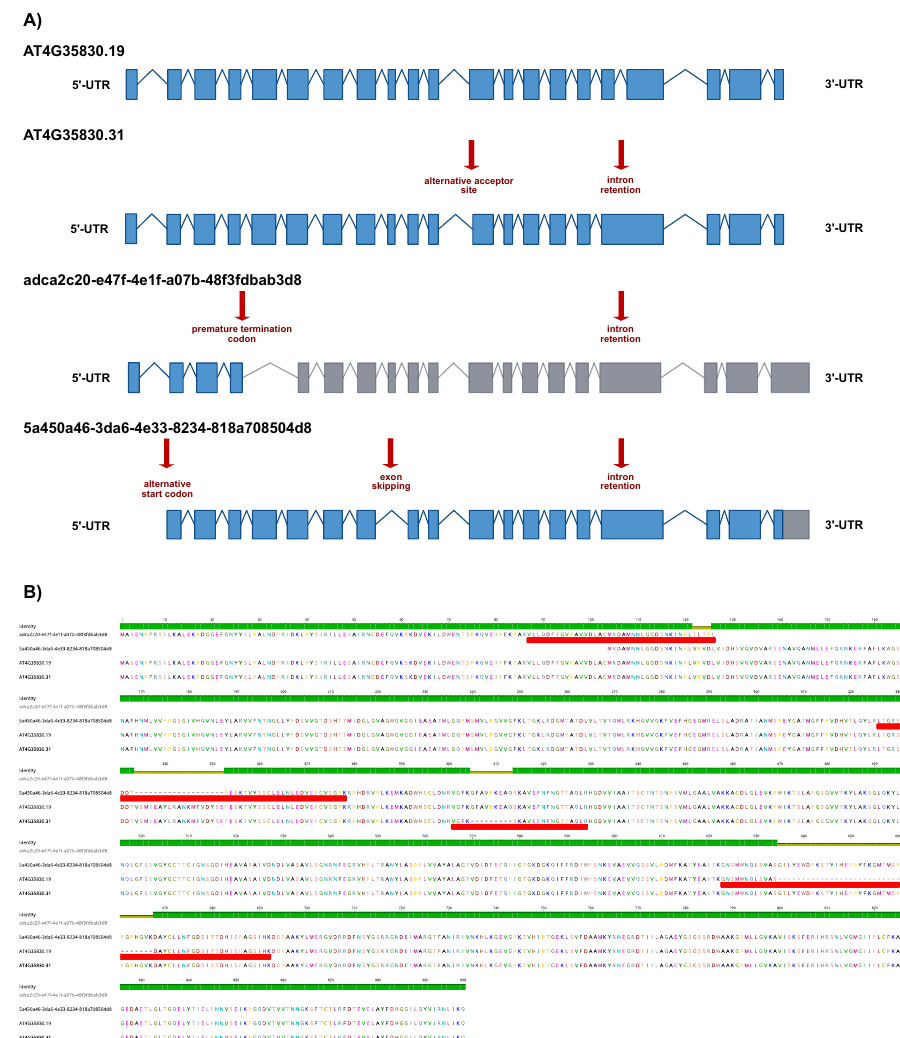
Figure 4. ACONITASE 1 proteoforms characterization in Arabidopsis senescent leaves employing a combined long-read proteogenomic approach. ( A ) Schematic representation of the ACONITASE 1 (ACO1) transcript isoforms corresponding to the proteoforms identified in the protein search per- formed with the AtRTD3_AtONT-DRS protein database. Boxes represent exons and lines represent introns. Exons colored in blue are translated, while exons in grey are not according to the protein translation prediction performed with TranSuite. Red arrows highlight characteristic alternative splicing- and coding-related features in each transcript isoform. ( B ) Alignment of the ACO1 proteo- forms identified in the protein search performed with AtRTD3_AtONT-DRS. Red boxes indicate the unique peptides identified in each case. The identity graph displays the degree of identity across all sequences for every position. Green means that the residue at the position is the same across all sequences. Positions with 30% to under 100% identity are represented in